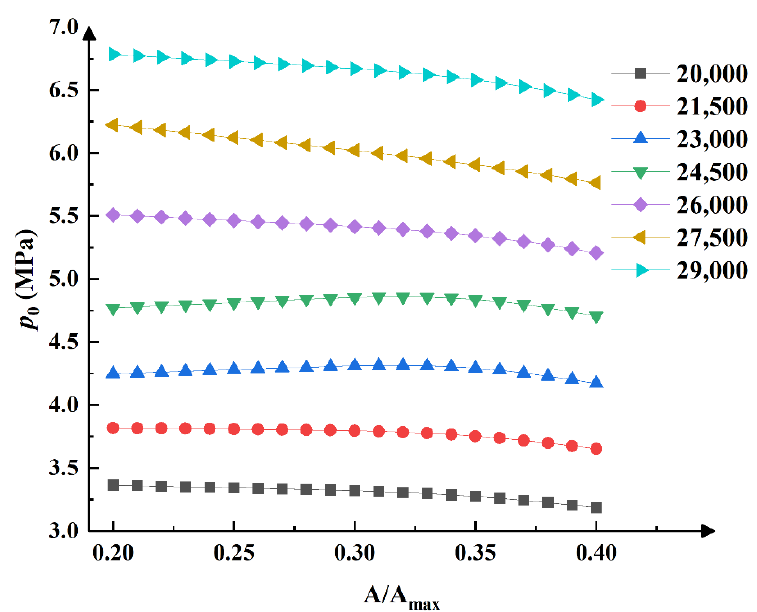
Figure 15. Pressure of pump outlet vs. speed and valve opening under low operating conditions.